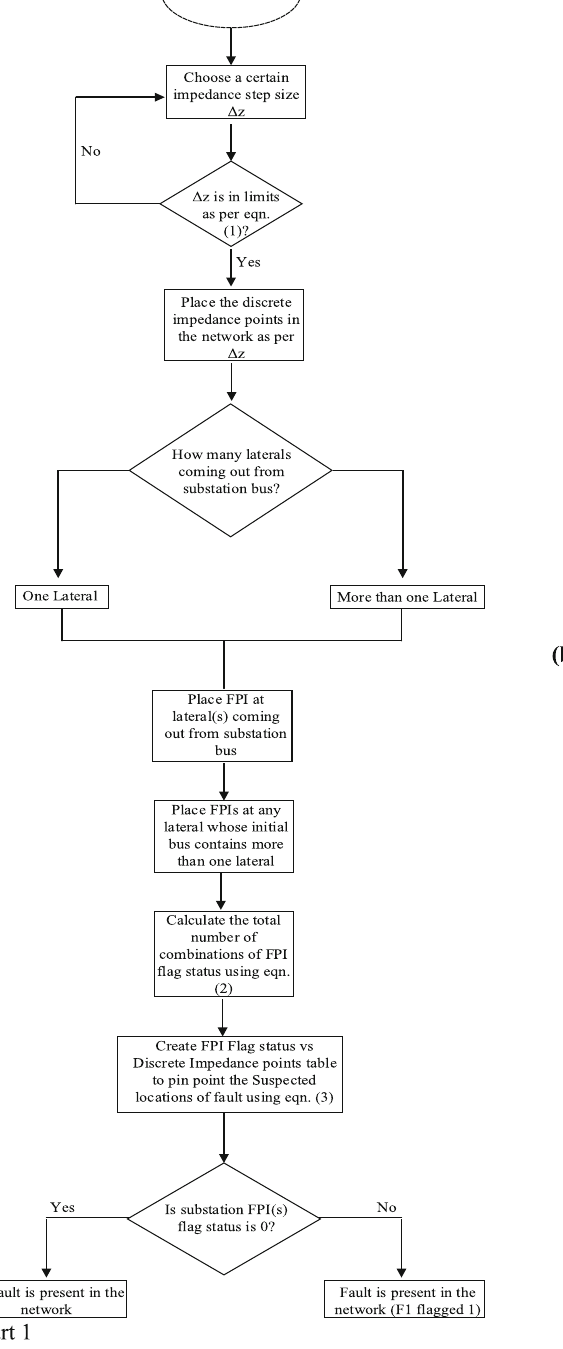
Fig. 5 Flow chart to enhance network